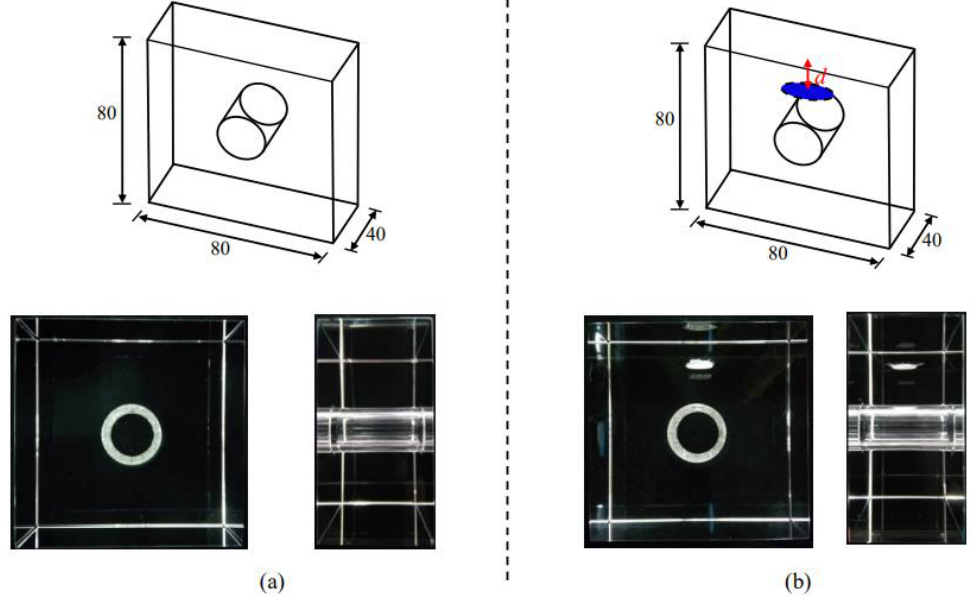
Figure 1. Sample design: ( a ) samples without internal cracks; ( b ) samples with internal cracks.